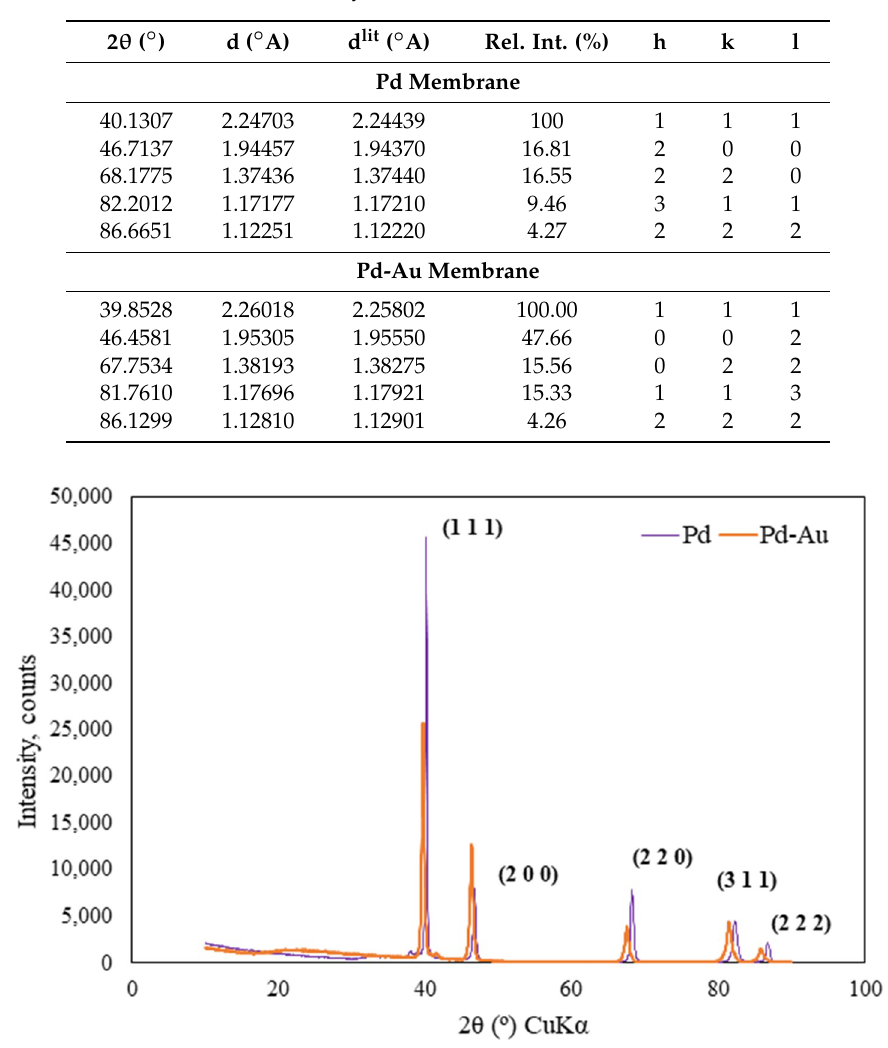
Table 4. XRD analysis for Pd and Pd-Au MRs at 400 °C.